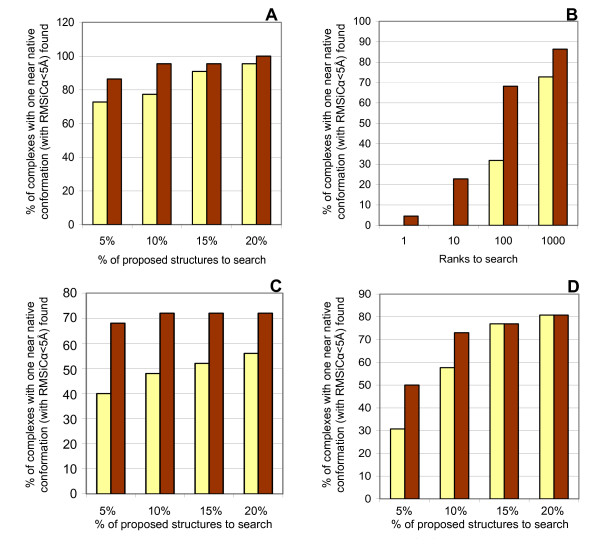
Improvement of prediction quality (ZDOCK 2 benchmark). The light yellow bars show the percentage of complexes for which a near-native solution (RMSiCα<5Å) is found without the optimised weighting factors. The brown bars show the results after the application of the weighting factors. (A/B) for enzyme-inhibitor (C) for antibody-antigen and (D) for other complexes; (100%: 22 enzyme-inhibitor complexes, 25 antibody-antigen complexes and 22 other complexes); an enrichment of complexes with near-native structures on the lower ranks for all complex classes can be seen.